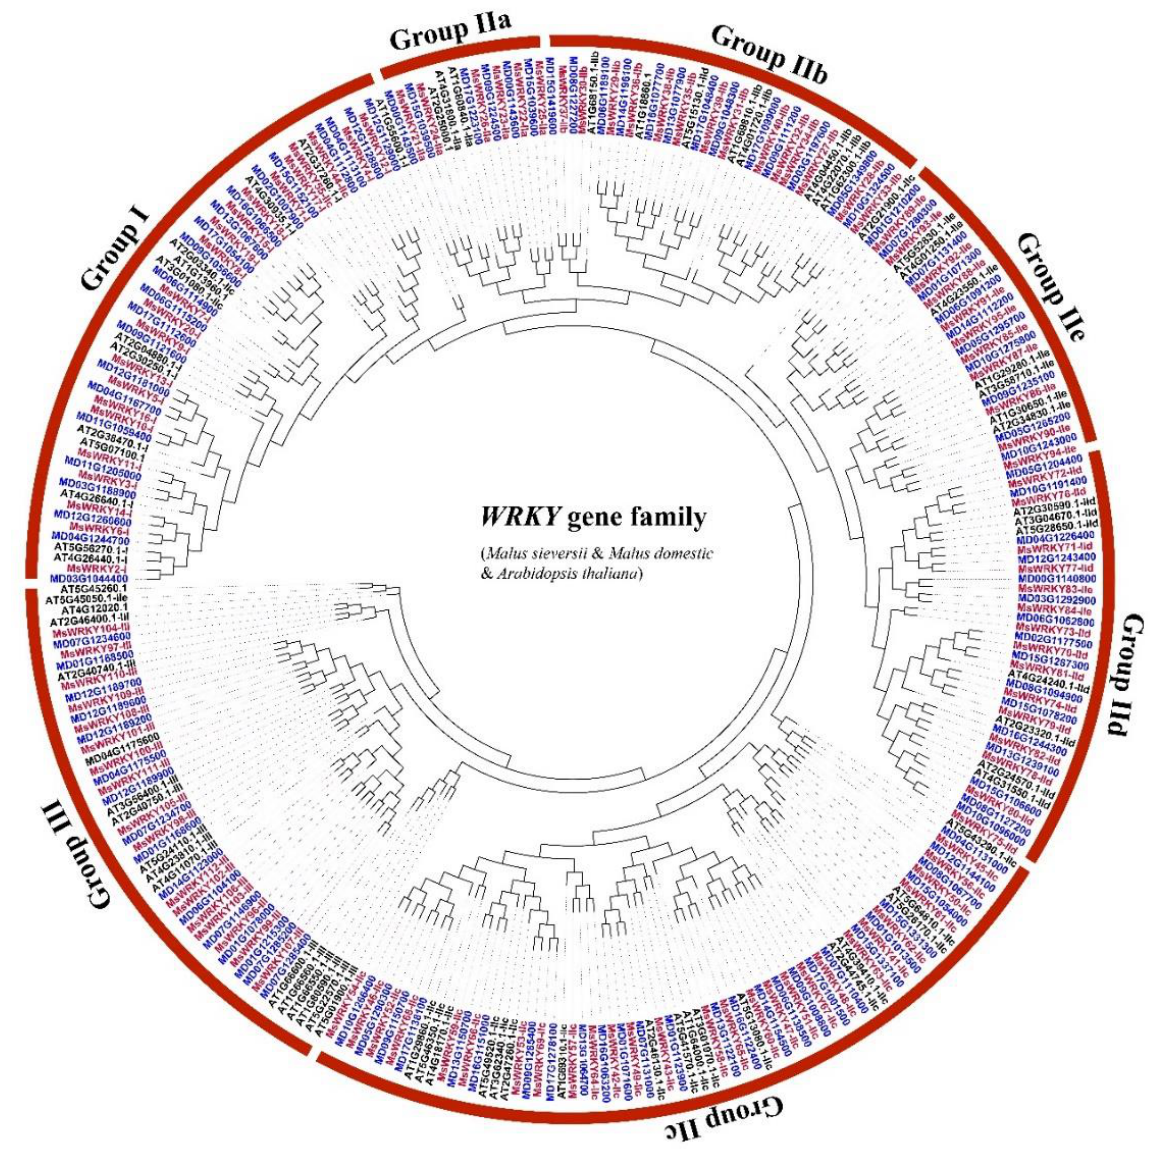
Figure 1. Phylogenetic analysis of the WRKY proteins among M. sieversii (red), M. domestica (blue) and A. thaliana (black). The phylogenetic tree was constructed using the Neighbor-Joining method. The bootstrap test was performed with 1000 replicates. The WRKY proteins of M. sieversii , M. domestica and A. thaliana were marked in red, blue and black.